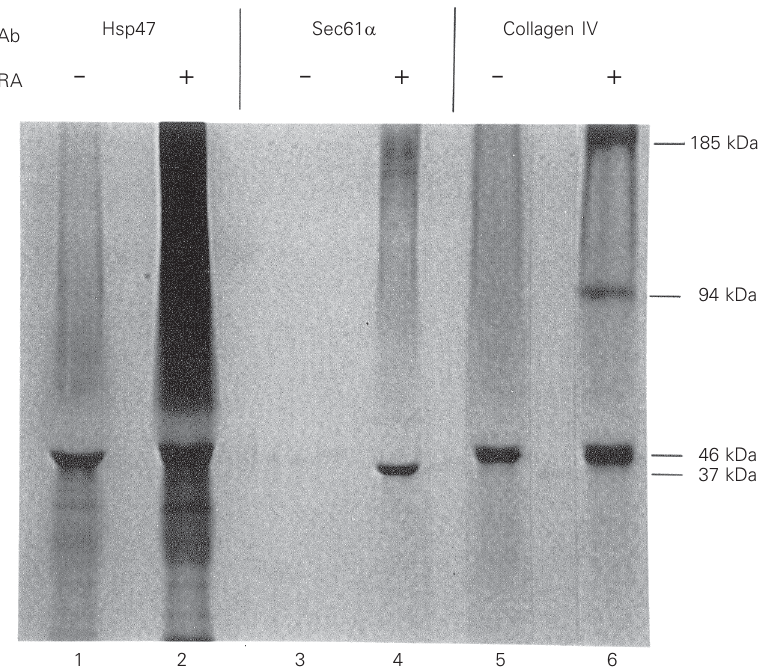
Figure 1. Immunoprecipitation of membrane-bound polysomes (microsomes) with anti- Hsp47, anti-Sec61 (cid:1) , and anti-collagen IV antibodies after retinoic acid treatment of F9 cells. Cells treated (lanes 2, 4 and 6) or not (lanes 1, 3 and 5) with retinoic acid for 4 days were labeled for 1 h with 35 S-methionine. Microsomes were immonoprecipitated with anti-Hsp47 (lanes 1 and 2), anti-Sec61 (cid:1) (lanes 3 and 4), and anti-collagen IV (lanes 5 and 6) antibodies. Ab: antibody; RA: all-trans retinoic acid. Molecular masses of standard proteins are given on the right side of the